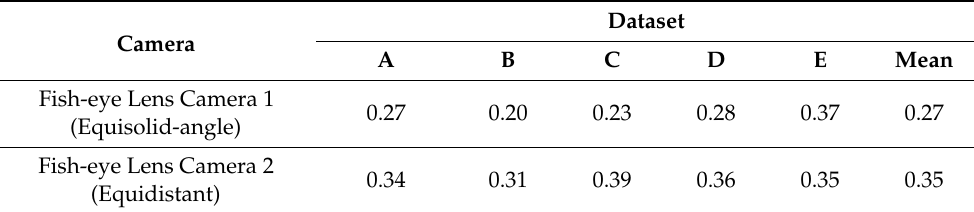
Table 14. RMS-residuals of IOPs in real